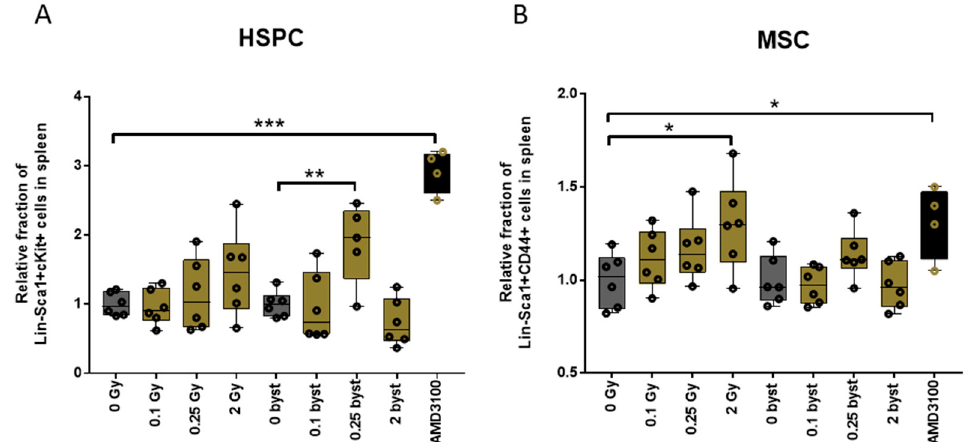
Figure 10. Bone Marrow-Derived Extracellular Vesicles from Low-Dose Irradiated Mice Induce Migration of Hematopoietic Stem and Progenitor Cells into the Spleen in Bystander Mice. Lin-Sca1+cKit+ hematopoietic stem and progenitor cells ( A ) and Lin-Sca1+CD44+ mesenchymal stromal cells ( B ) in the spleen were measured by flow cytometry 24 h after irradiation or injection of extracellular vesicles. Isolation of spleens and splenocyte phenotyping was performed as described in the Materials and Methods section. Black bars represent positive control mice treated with AMD3100. Mean, minimum and maximum values are shown, error bars represent SD. N = 6, significance tested by